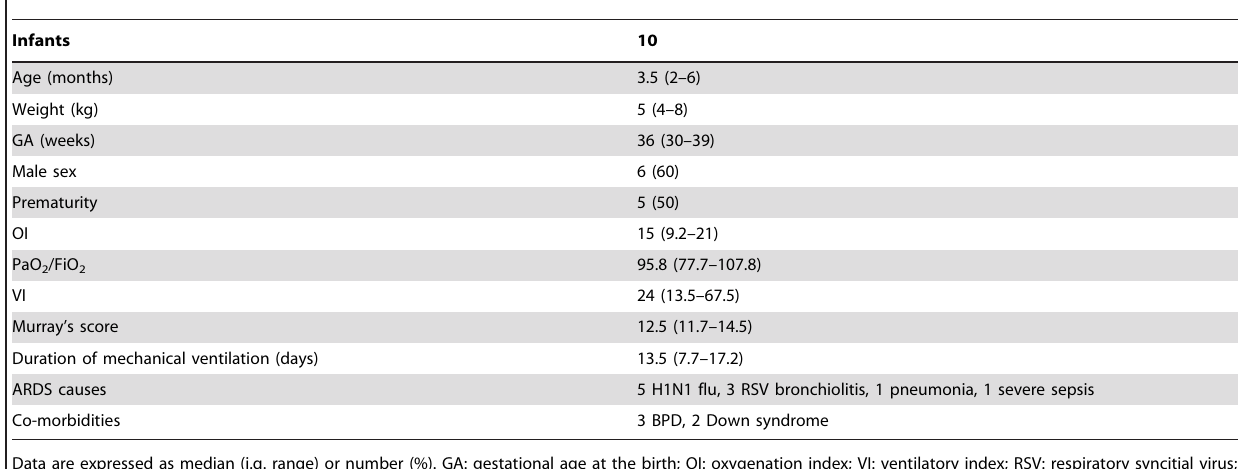
Table 1. Clinical data.